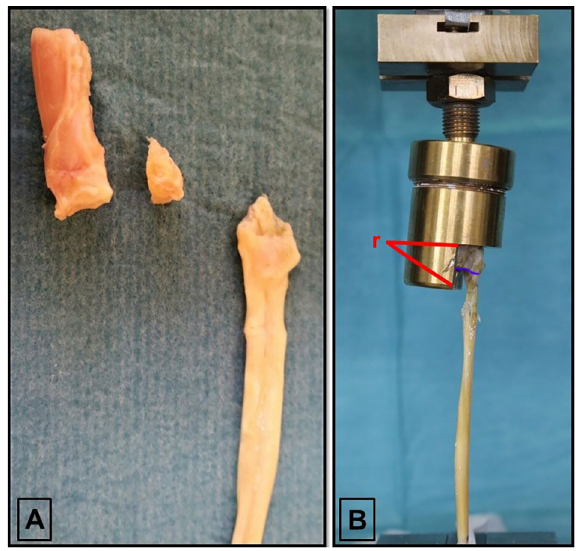
Figure 4. ( A ) Specimen preparation and injury simulation prior to repair. ( B ) Repaired specimen secured in the DP holding cylinder mounted on the tensile testing machine. Distance (r) indicating the 10 mm reference for further image